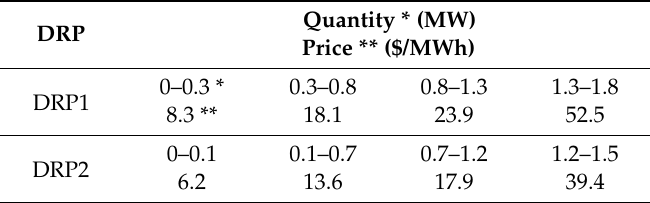
Table 3. Bid quantity offer packages of